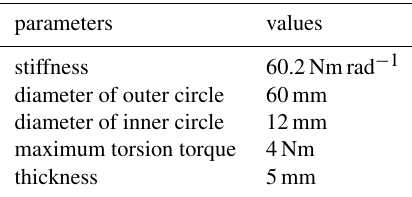
Figure 11. HRI measurement with respect to time. If the torque is zero, the output HRI with the elastic module is close to zero. When the torque drives the elastic module, the HRI will change between the positive interval and the negative interval. Table 4. Properties of the